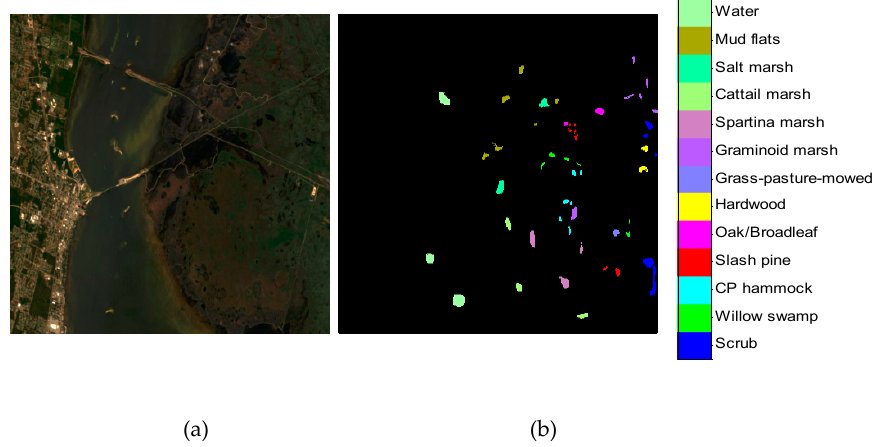
Figure 6. ( a ) False-color image of the Ground-truth map of the KSC data, and ( b ) Ground truth of the Figure 6. (a) False-color image of the Ground-truth map of the KSC data, and (b) Ground truth of the KSC data. KSC data. Table 4. Land cover classes and numbers of samples in the Salinas data set.